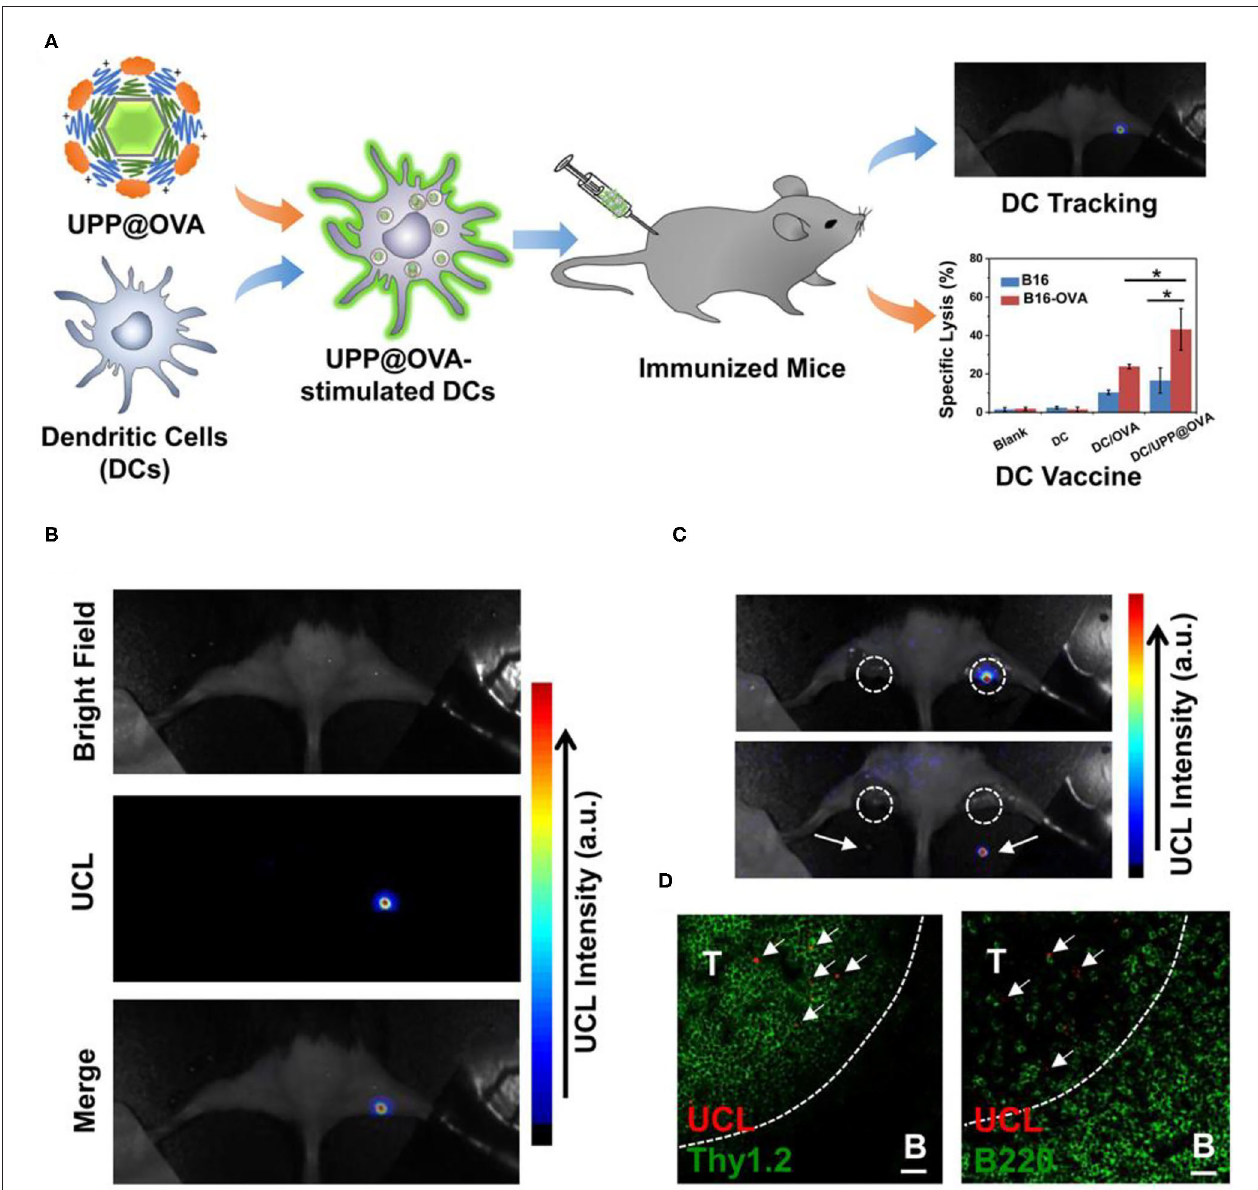
FIGURE 2 | (A) Schematic illustration of antigen-loaded UCNPs for DC stimulation, tracking, and vaccination in DC-based immunotherapy. (B) Labeled DCs were injected into the right footpad of a mouse; 48 h after injection, strong UCL signals from the draining lymph node were seen under in vivo UCL imaging. (C) Ex vivo imaging of popliteal lymph nodes (white circles) before (top) and after (bottom) being dissected from the mouse. (D) Immunofluorescence images of the lymph nodes dissected from the mouse injected with UPP@OVA-labeled DCs. T, T-cell zone (Thy1.2þ); B, B-cell zone (B220þ). Scale bar = 20 µ m. Arrows point to UCL signals from labeled DCs. Copyright 2015, American Chemical Society (Xiang et al., 2015). * P <